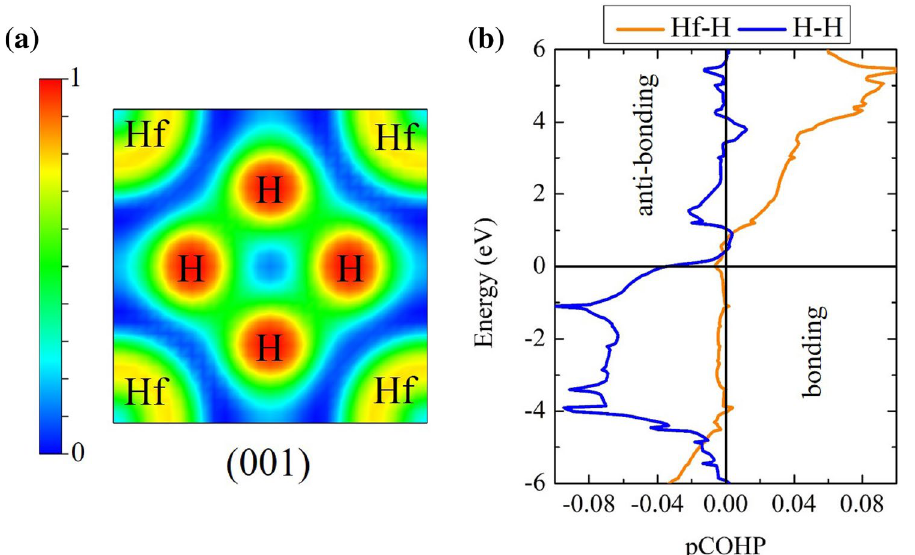
Figure 5. The 2D-electron localization function (ELF) in the sodalite-like clathrate hafnium hexahydride structure at 600 GPa (drawn by VESTA (ver. 3.4.7) 51 (URL https:// jp- miner als. org/ vesta/ en/ downl oad. html)). ( b ) Projected crystal orbital Hamilton populations (pCOHPs) in the sodalite-like clathrate hafnium hexahydride structure at 600